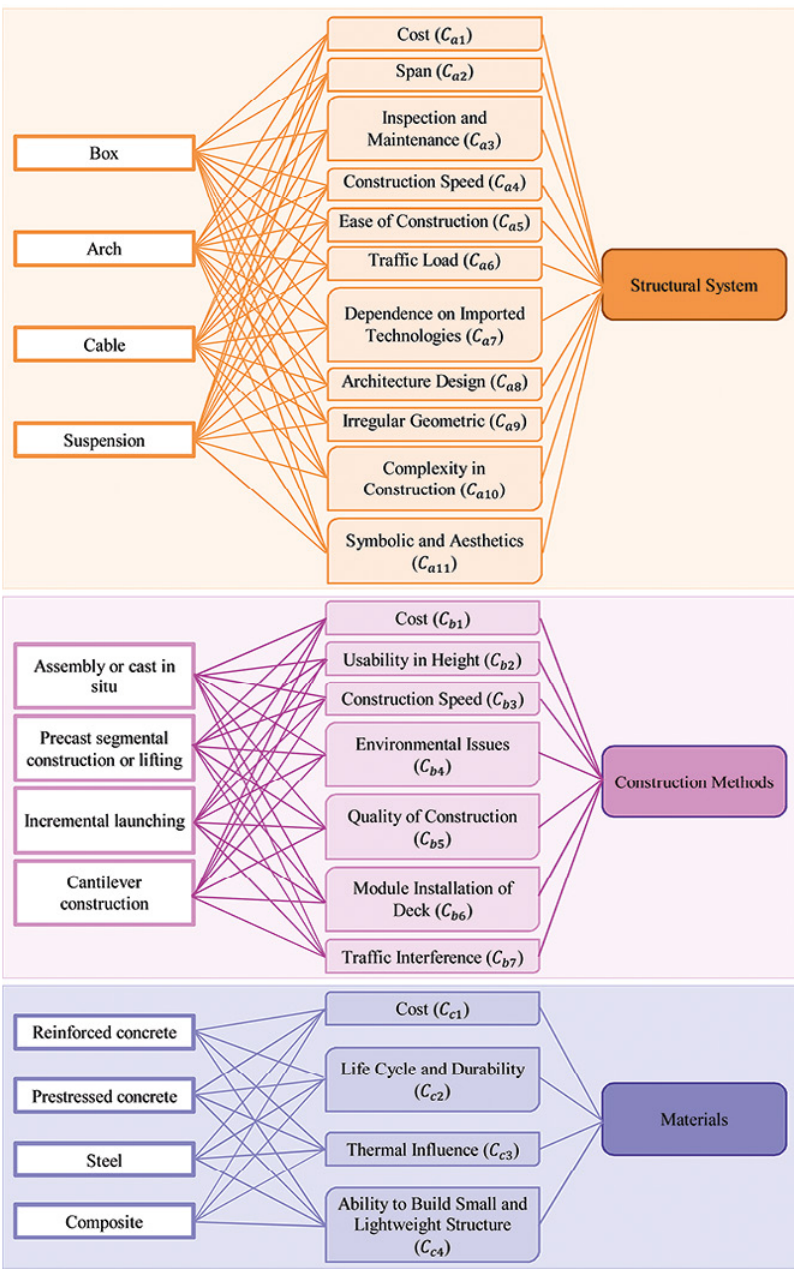
Figure 3. The hierarchical structure of the